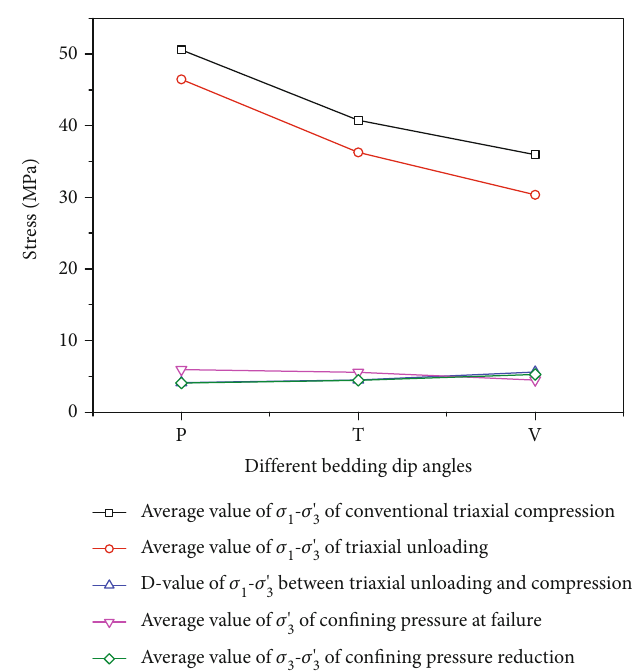
Figure 5: Comparison of test results for di ff erent layered dip coal